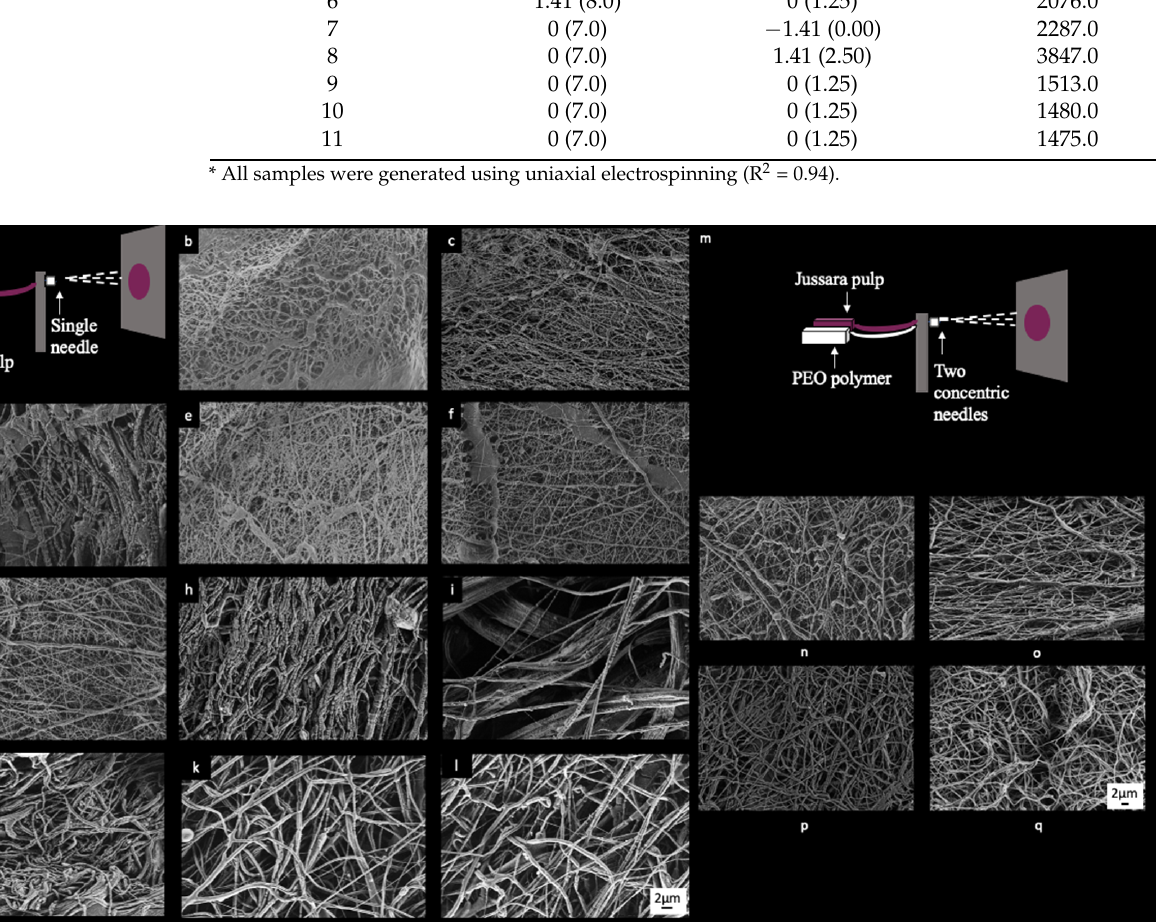
Table 1. Coded and experimental values and the diameter measurements (nm) of core-shell nano- fibers with jussara pulp.